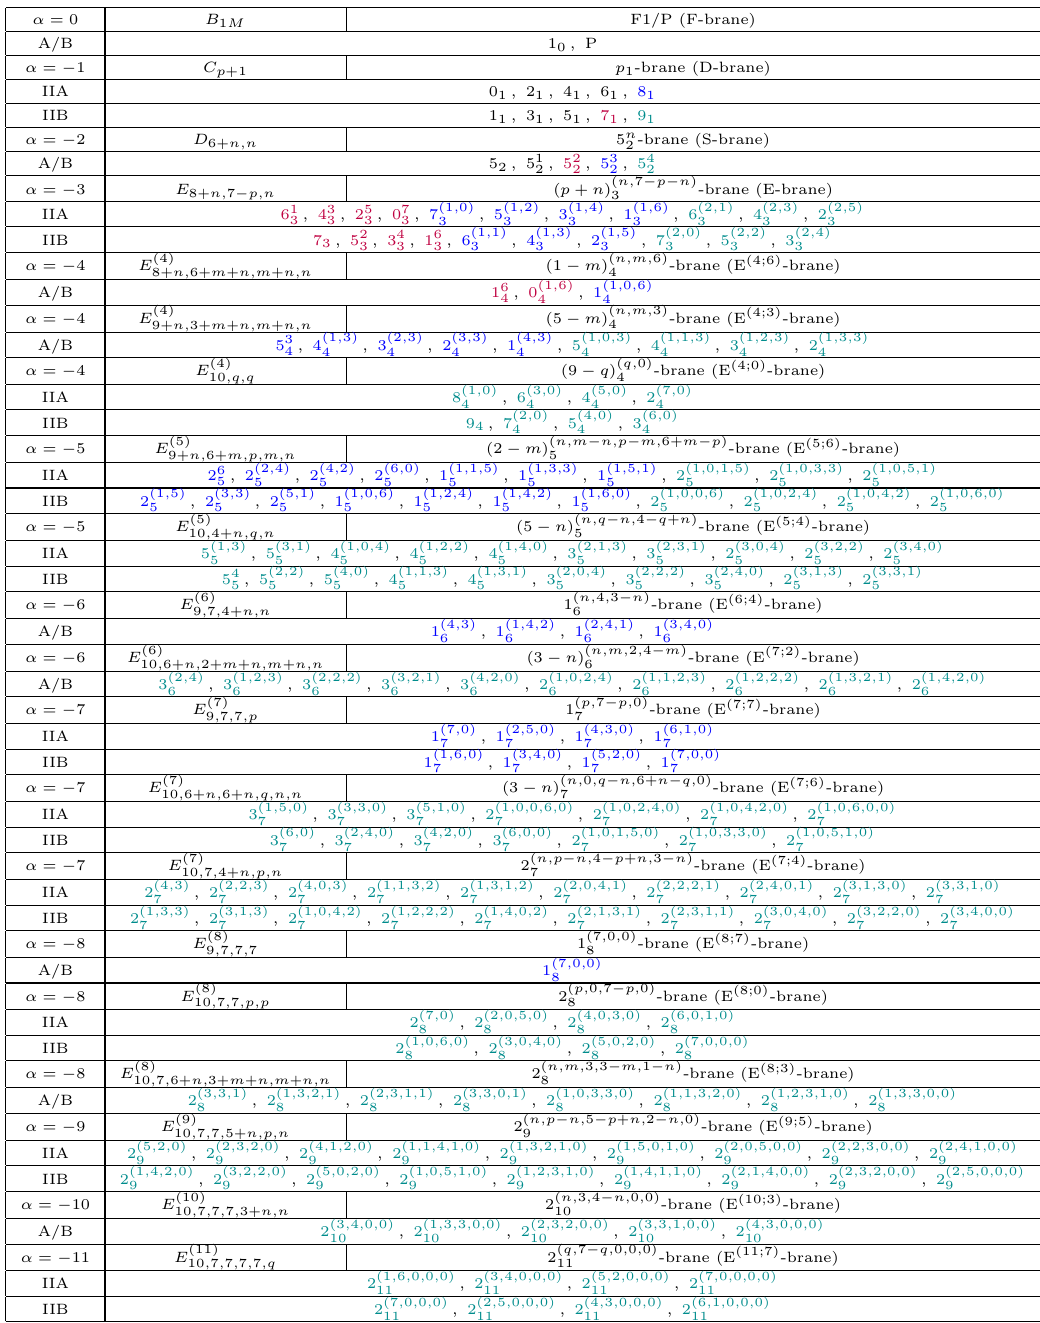
Table 6 . Exotic branes with the tension proportional to g α mixed-symmetry potentials in type II string theories. Here, n and m are non-negative integers while p ( q ) runs over non-negative even/odd (odd/even) numbers in type IIA/IIB theory.